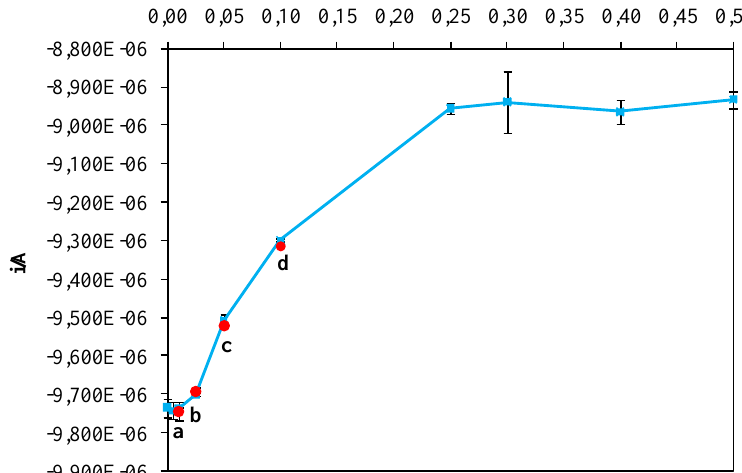
Figure 2. Curve of the AFM samples a, b, c and d (red circles). Vertical bars represent standard errors (not shown when smaller than the